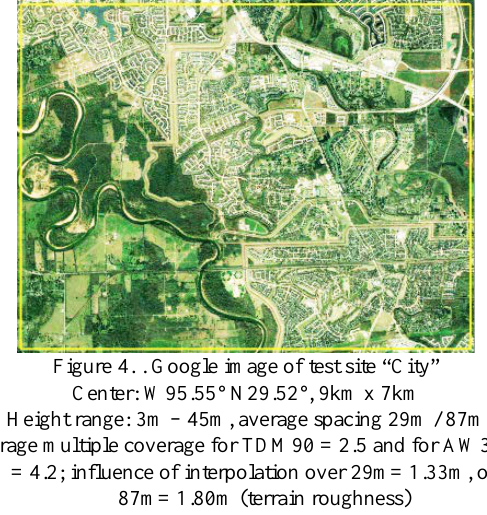
Figure 4. . Google image of test site “City” Center: W95.55° N29.52°, 9km x 7km Height range: 3m – 45m, average spacing 29m / 87m = 4.2; influence of interpolation over 29m= 1.33m, over 87m= 1.80m (terrain roughness)